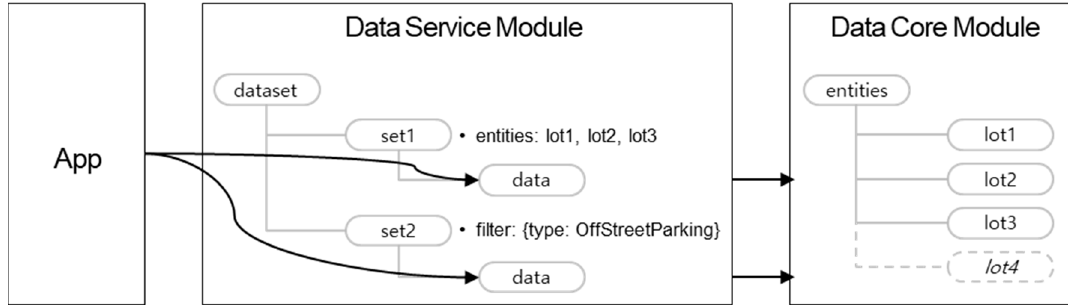
Figure 5. Dataset management with data core.